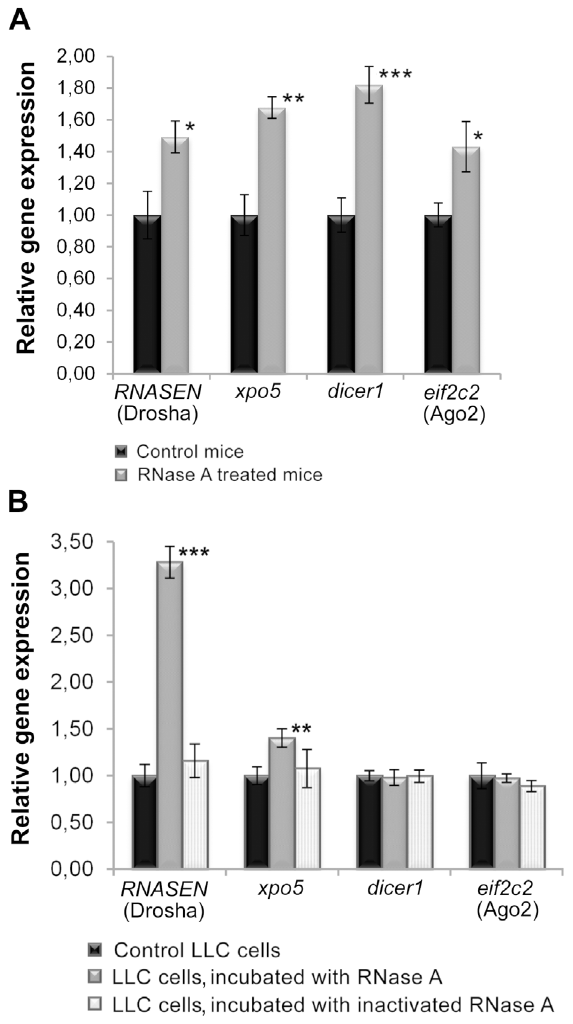
Figure 5. qPCR analysis of the expression of miRNA processing genes. A . Expression of miRNA processing genes in LLC tumour tissue from mice that received RNase A therapy. B . Expression of miRNA processing genes in LLC cells incubated in vitro with intact and DEPC- inactivated RNase A for 48 h. *, **, and *** denote a statistically significant difference relative to the control with p , 0.05, p , 0.01 and p , 0.001, respectively. hprt1 and rpl30 were used as reference genes.